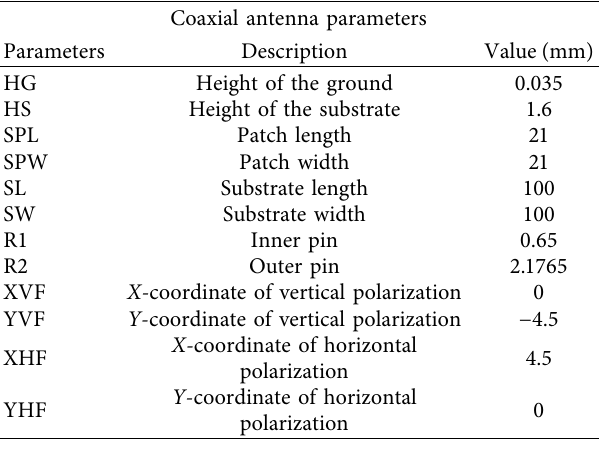
Figure 2: Geometry of S-band dual port element. Table 1: Dimensions of the antenna design prototype of coaxial antenna.